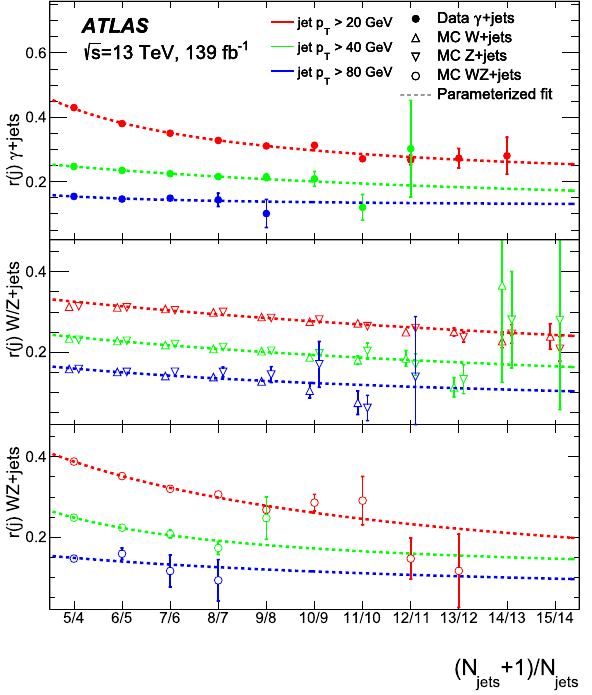
Fig. 3 The ratio of the number of events with ( j + 1 ) jets to the number with j jets in various event samples (details in the legend), used to validate the jet-scaling parameterization. In the MC samples of W / Z / W Z +jets the vector bosons are forced to decay to leptons.